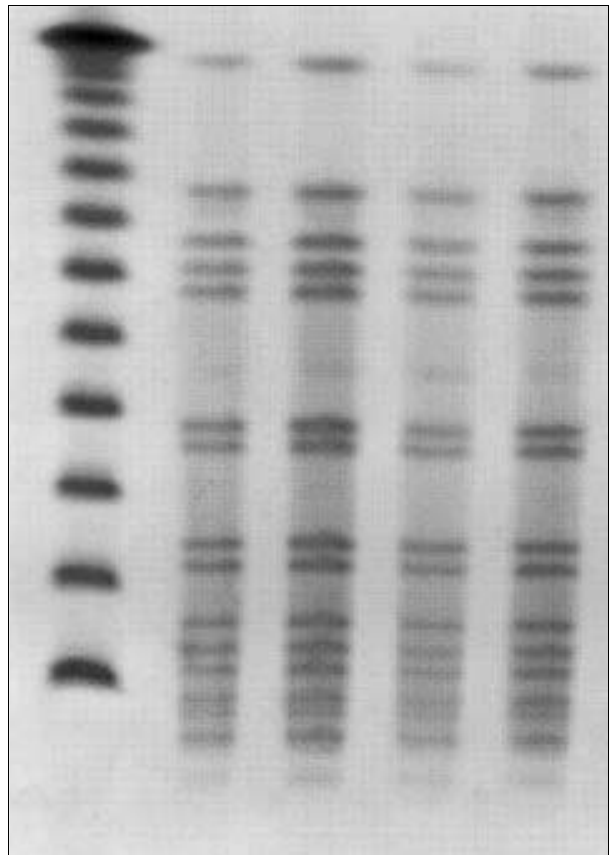
Figure 1) Sma I-generated pattern obtained by pulsed field gel elec- trophoresis of the methicillin-resistant Staphylococcus aureus (MRSA) isolates from community cases in southwestern Manitoba. Lane 1, lambda ladder standard; lanes 2 to 5, representative MRSA isolates of four different individuals from community